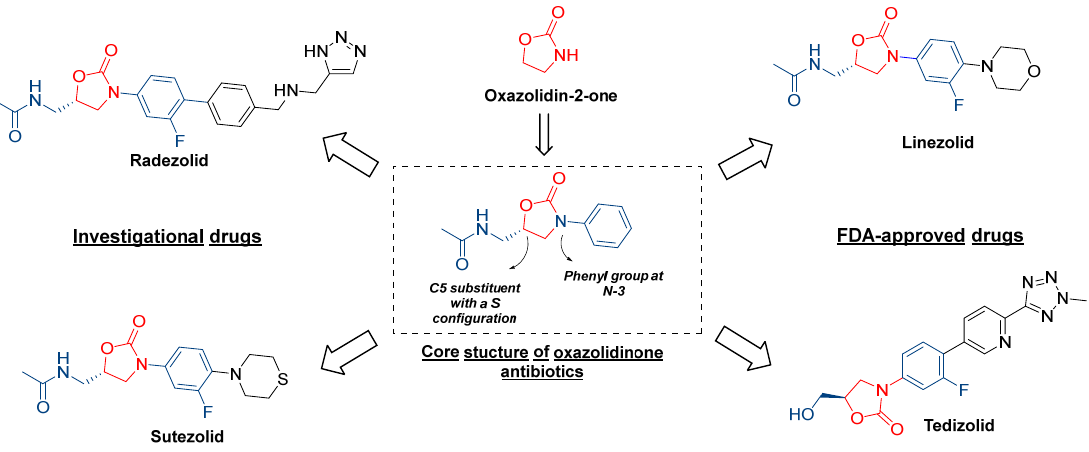
Figure 1. Development of oxazolidinone-based drugs.